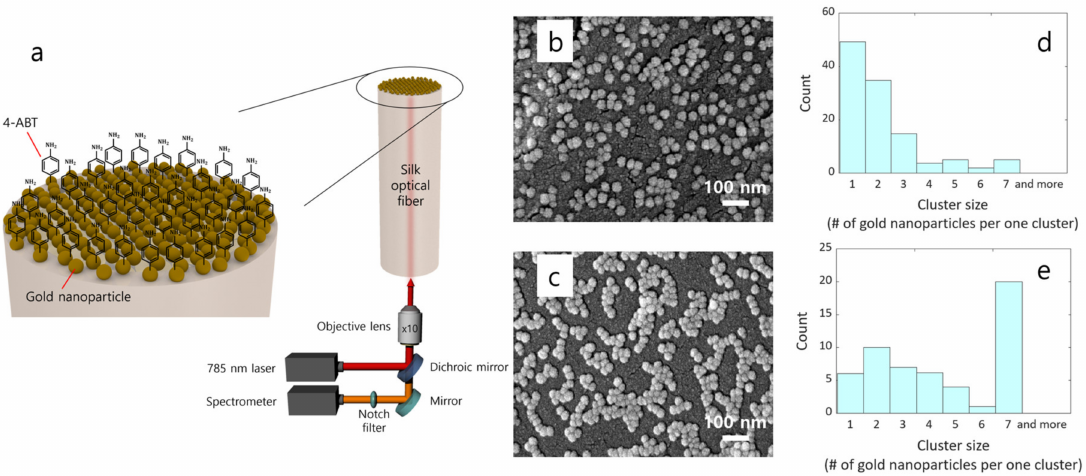
Figure 3. Silk-based fiber-optic SERS probe with gold nanoparticles ( a ). A schematic diagram of the SERS measurement setup and FE-SEM images of gold nanoparticles distributed on top of ( b ) a silk fiber and ( c ) a multi-mode fiber are presented. Histograms of the cluster size distribution were computed for ( d ) the silk and ( e ) the silica multi-mode fibers,